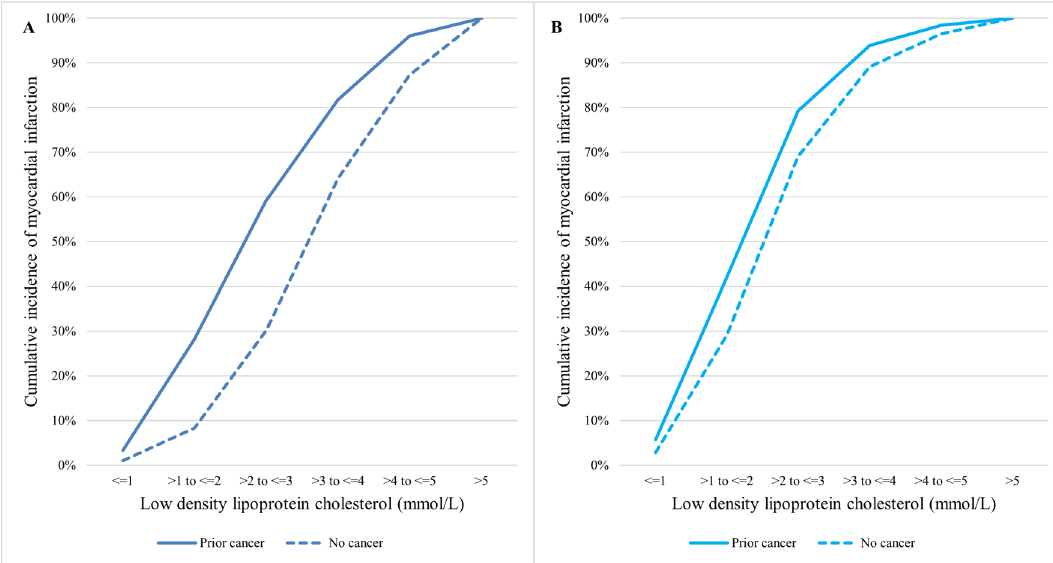
Figure 3. Cumulative incidence of myocardial infarction in patients not on prior LLT ( A ) and on prior LLT ( B ) in relation to LDL-C by cancer status. The solid lines represent the prior cancer group whilst the dotted lines represent the no cancer group. LDL-C: low density lipoprotein cholesterol; LLT: lipid lowering therapy.